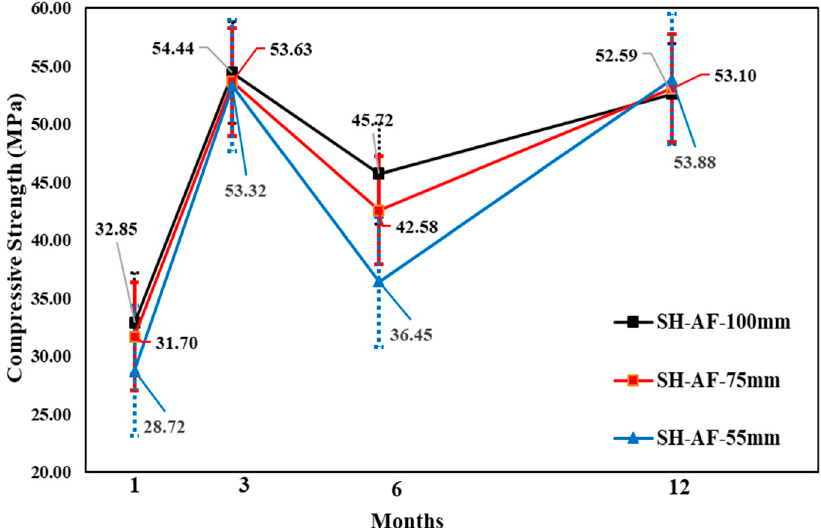
Figure 13. Compressive strength of alkali-free accelerator mix core by